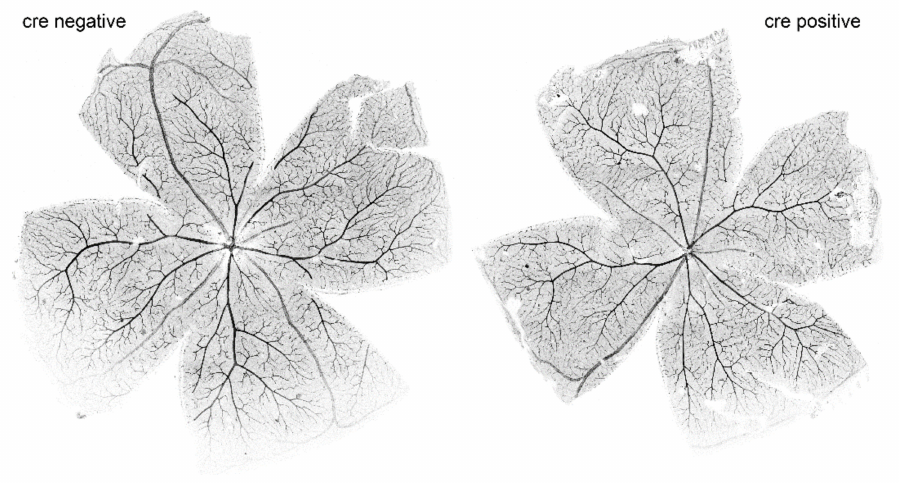
Figure 9. Retinal whole mounts from 12-week-old mice with blood vessels labelled with Isolectin B4. In order to check further properties of the vascular network, retinas of both groups were evaluated using the AngioTool software, similarly to the retinal whole mounts of P6 mice. Several parameters of the vascular network were determined (Figure 10). There were no differences between the two groups except for the average vessel length between two junction points.